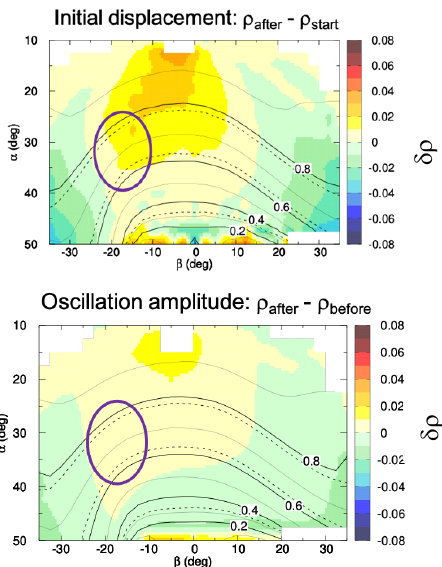
Fig. 6 . Displacement dr of the ECCD location due to pellets n e modifications by varying toroidal and poloidal angles for reference pellets (1 mm) (top: between the case just after pellet and without pellet, bottom: between the case just after pellet and just before pellet). Black contours: reference ECCD location (before pellet injection). Dashed lines represent the rational q surfaces for the DTT full power scenario (R=2.14 m configuration). Violet ellipse highlights the optimized intervals of injection angles which reach the rational q surfaces 2 and 3/2.